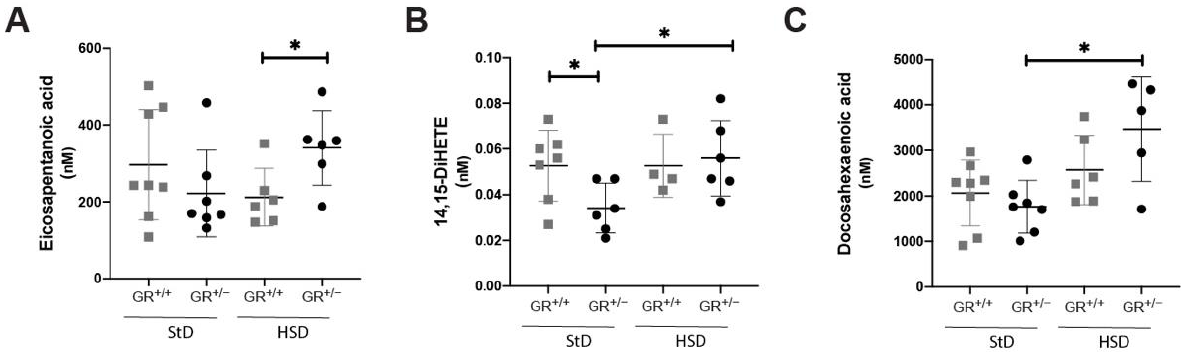
Figure 6. Fatty acid disturbances in eicosapentanoic and docosahexaenoic acid pathways of GR +/ − rats. Metabolites of ( A ) eicosapentanoic acid, ( B ) 14,15-DiHETrE and ( C ) docosahexaenoic acid measured in plasma of GR +/+ (StD n = 8, HSD n = 6) and GR +/ − rats (StD n = 7, HSD n = 6) under standard or high salt diet. Values are indicated as mean ± SEM, and data were evaluated by two-way ANOVA and compared with Tukey test and differences assessed at * p < 0.05.